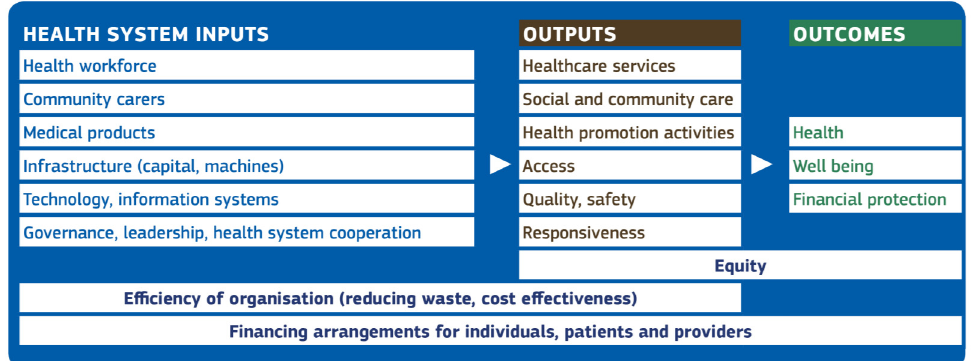
Figure 1. Multi-dimensional Health and Social Care Systems (MHSCS) conceptual framework. Source: Expert Panel Opinion [10].